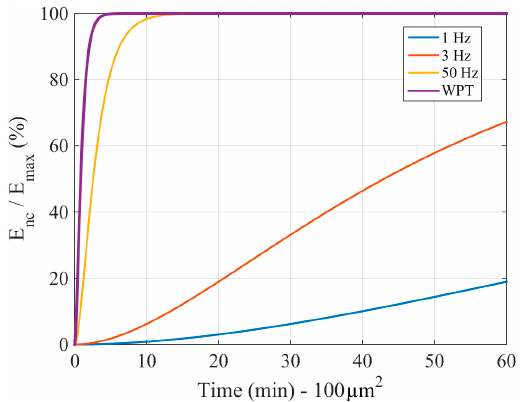
Figure 5. Percentage of energy stored as a function of time for different energy source frequencies.